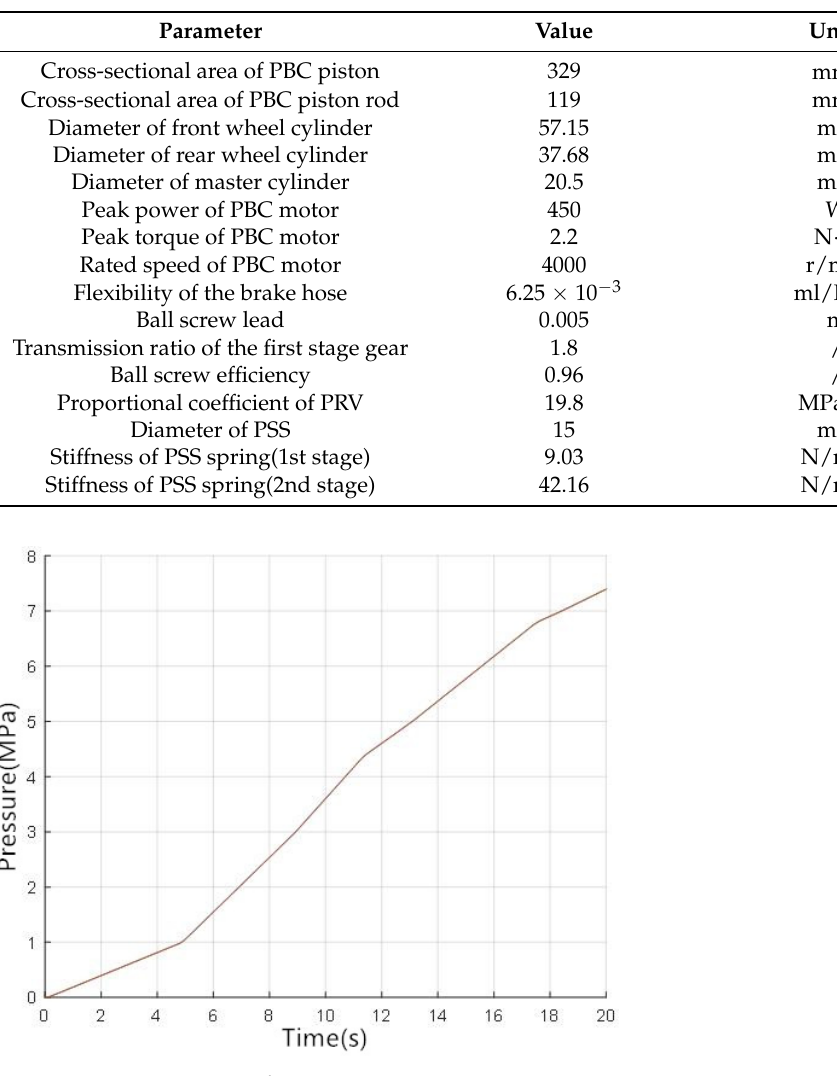
Figure 12. Pressure curve of PBC.